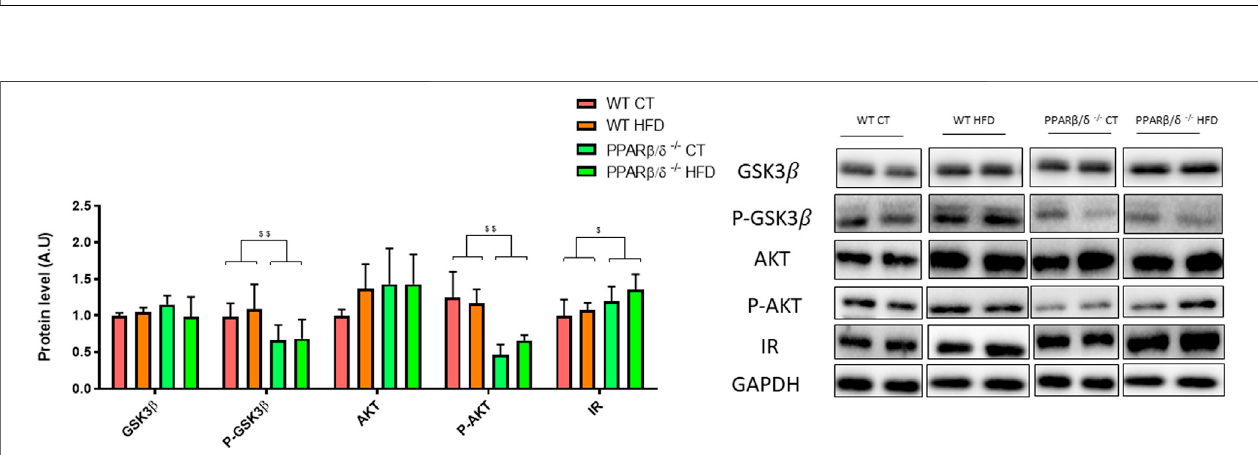
FIGURE 6 | Semi-quanti fi cation of protein levels for TLR4, NFK β , and PTP1B where two representative samples out of four per group are shown. All results are presentedasMEAN ±SD.Groupswerecompared against eachotherusingtwo-wayANOVA ( n ≥ 4)(CTvs.HFD: ## denote p < 0.01; WTvs.PPAR β / δ -/- : $ denotes p < 0.05).InthecaseofTLR4,Tukeypost-testwasperformed(WTCTvs.PPAR β / δ -/- HFD:**denote p < 0.01;WTCTvs.PPAR β / δ -/- CT:***denote p < 0.001;WTHFDvs. PPAR β / δ -/- CT: * denotes p < 0.05).